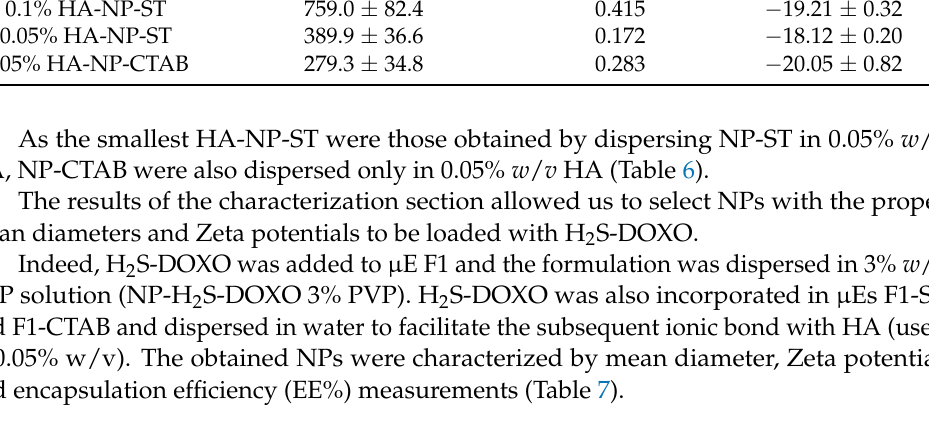
Table 7. Mean diameters, Zeta potentials, and EE% of H 2 S-DOXO-loaded